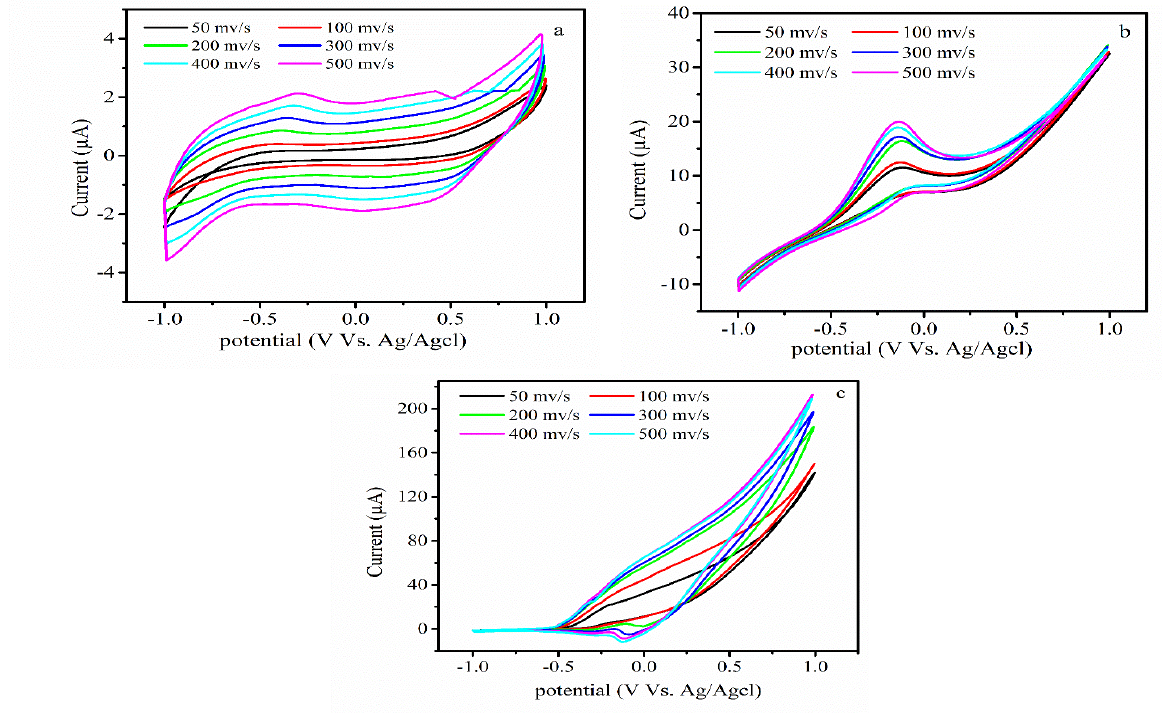
Figure 5: Cyclic voltammetry (cv) of (a) the Si(100) wafer photocathode, (b) SiNWs photocathode prepared by etching for 15 min, and (c) the SiNWs photocathode prepared by etching for 30 min.